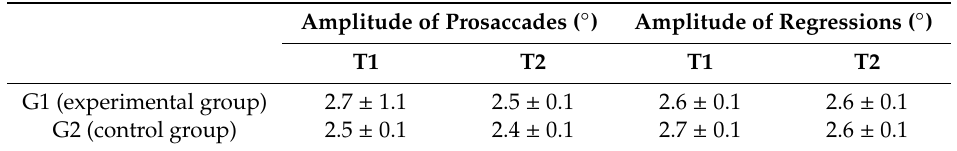
Table 2. Means and standard deviations of the amplitude of prosaccades and regressions at T1 and T2 for both groups of children (G1 = experimental group; G2 = control group).